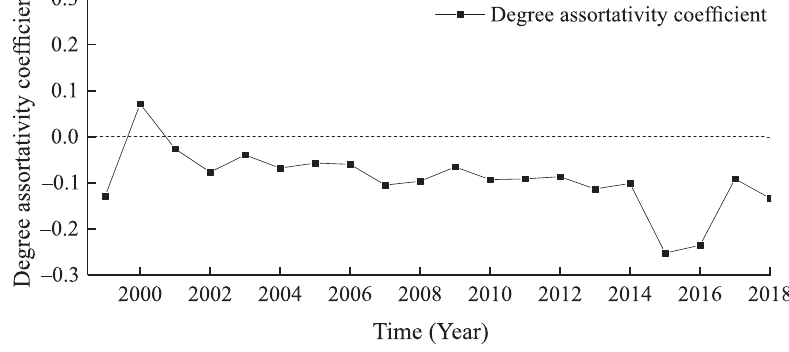
Figure 6. Evolution of node degree assortativity coefficient from 1999 to 2018